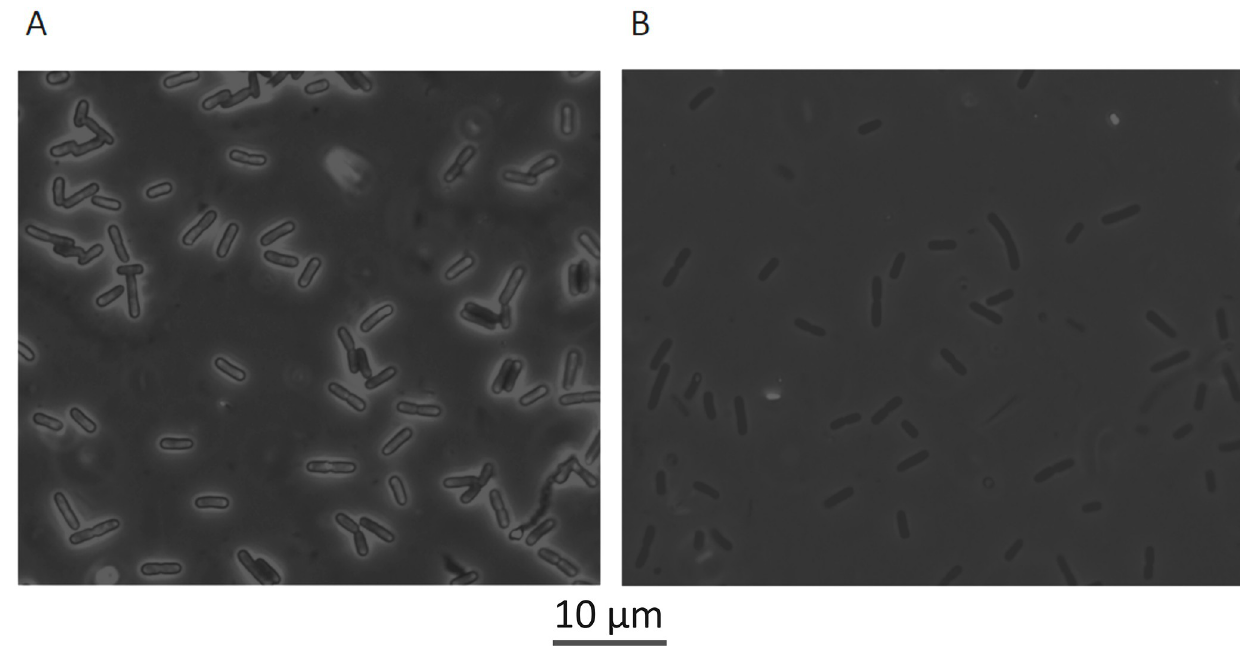
Fig 5. E . coli MG1655 treated for 30 minutes with 1/10xMIC (priming concentration) of pexiganan (A) and non-treated bacteria (B, control) observed under phase contrast microscopy. The specimens consisted of cells suspended in a 0.1% solution of nigrosin to create a strong contract to visualize the colanic acid capsules. Bacteria were observed with 1000X